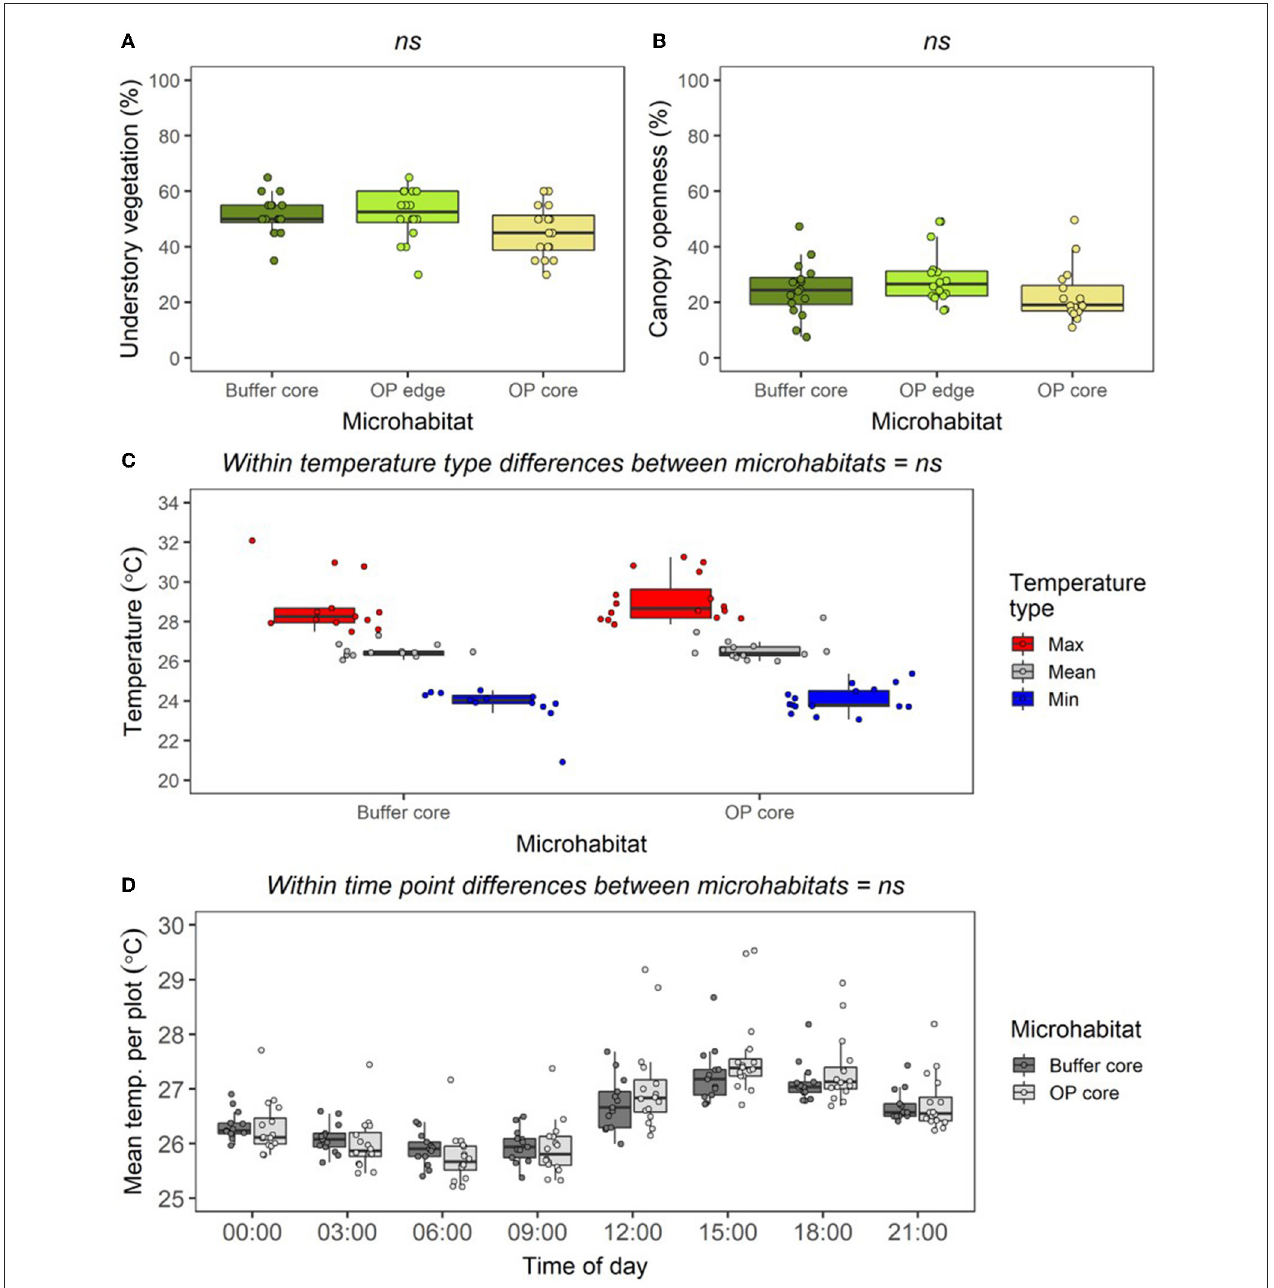
FIGURE 6 | Boxplots to show differences in percentage cover of understory vegetation (A) ; percentage canopy openness (B) ; mean, maximum, and minimum soil temperature (at depth of 5cm) per plot across all times combined (C) ; mean soil temperature per plot at different times of day (D) , between plots in the Buffer Core, OP Edge, and OP Core RERTA 1 vegetation plots. All data were collected from across all RERTA 1 treatments (treatments A, B, C, and D) during the pre-treatment time period. During this period, all points were mature oil palm, but Buffer Core plots were being managed in a “lower impact” way than the OP Edge and OP Core plots, with no herbicide application. The boxplots indicate median, and interquartile ranges across vegetation quadrats, with all raw data points overlaid as coloured circles. For the vegetation data n = 16 per microhabitat; for the temperature data, n = 16 for OP Core and n = 13 for Buffer Core (owing to datalogger breakages). Text above boxplots shows results of LLRT comparisons for differences between microhabitats: ns = not significant. substantially in Reduced plots (lsmeans p < 0.001; Figure 7C